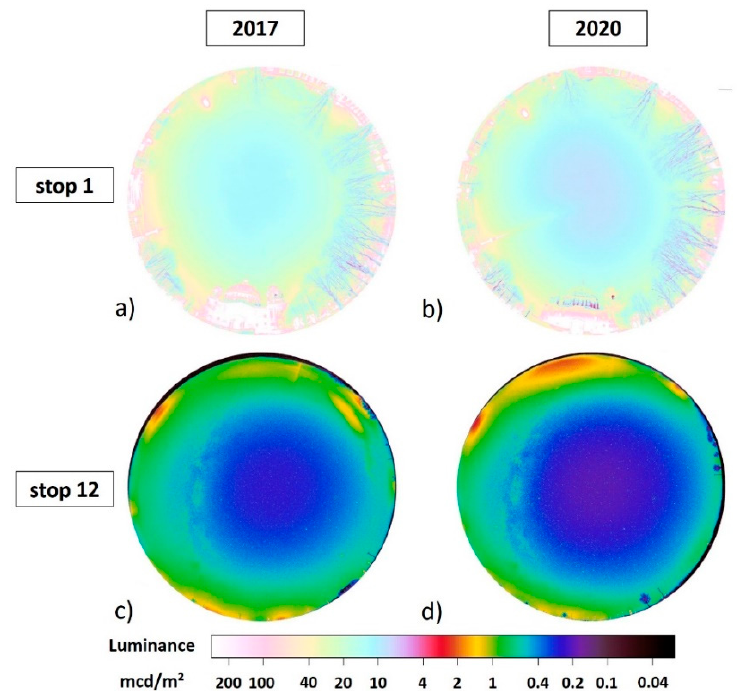
Figure 2. Luminance maps for two of the twelve stops near Berlin Germany. ( a , b ) stop 1 near city center and ( c , d ) stop 12 farthest away from the city center. ( a , c ) 2017—no lockdown and ( b , d ) 2020—lockdown. The full imaging dataset is given in Appendix A.